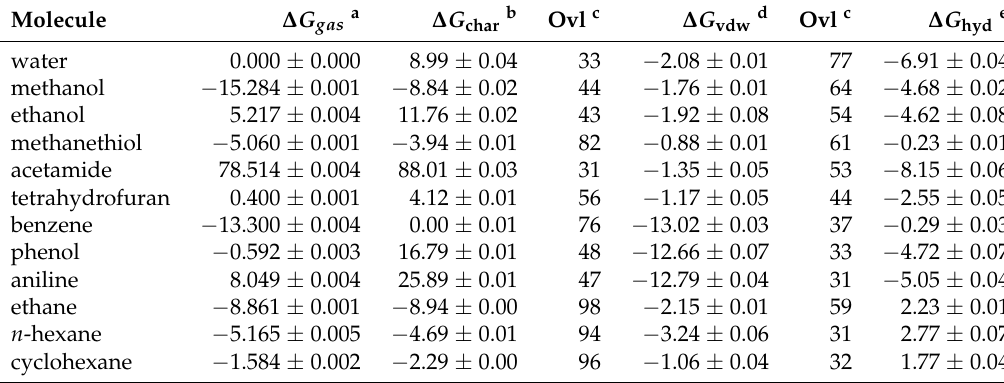
Table A1. Free energy differences of all substeps of the hydration free energy calculations with the CHARMM fixed charge force field in kcal/mol.